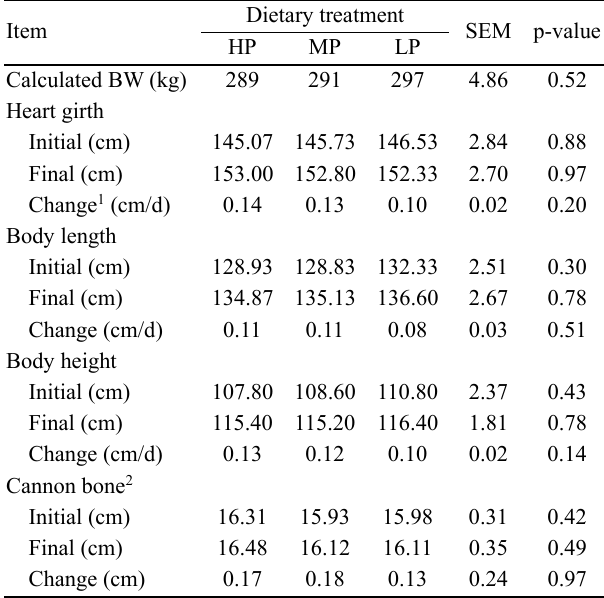
Table 3. Calculated BW, and body measurements of 8- to10-